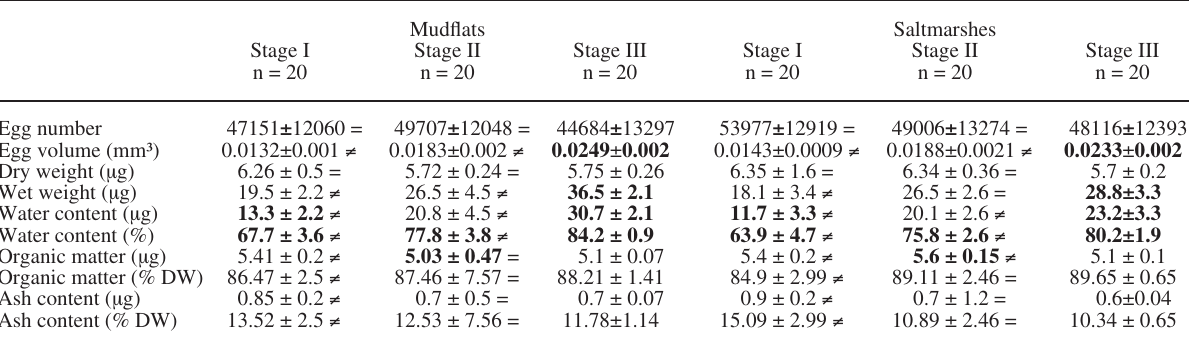
Table 2. – Neohelice granulata . number, volume, and biomass of eggs in three stages of embryonic development, comparing mudflats and saltmarshes (mean ± Sd). The symbol ≠ indicates significant differences between successive stages of the same habitat, while the numbers in bold indicate significant differences between habitats for the same stage.